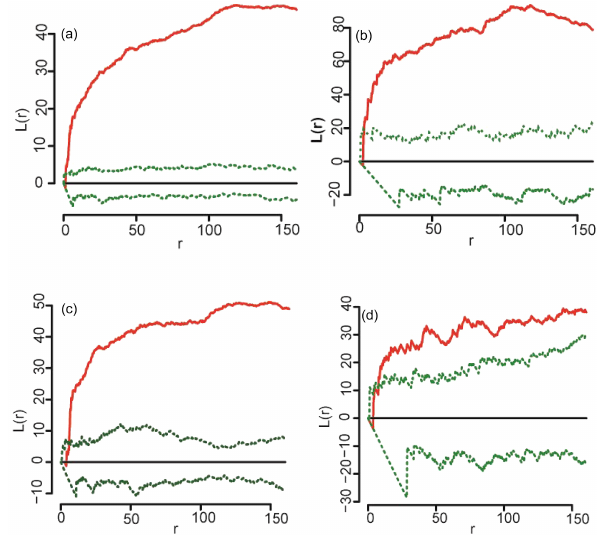
Figure 4. Ripley’s L(r) functions and Monte Carlo intervals for elm trees in different classes. Observed patterns (red color, straight line) fell above, below and within 95% Monte Carlo intervals (green color, dashed line). The spatial pattern of all elm trees with DBH ≥ 10cm in the fenced plot was shown in (a) . The spa- tial patterns of elm with three classes in the fenced plot were shown in (b) 10cm ≤ DBH ≤ 15cm, (c) 15cm<DBH ≤ 20cm and (d)